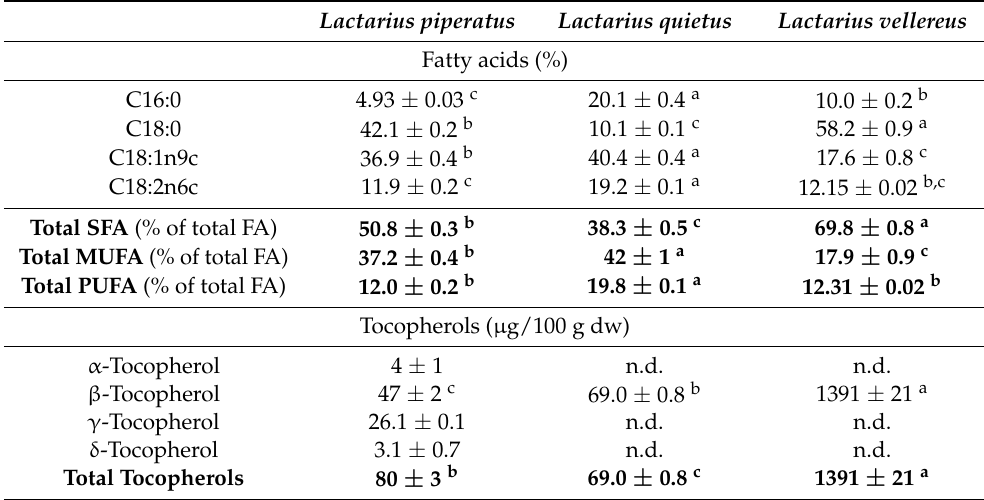
Table 3. Main fatty acids and tocopherols composition of the studied mushrooms (mean ± SD, n = 3). Lactarius piperatus Lactarius quietus Lactarius vellereus Fatty acids (%) C16:0 4.93 ± 0.03